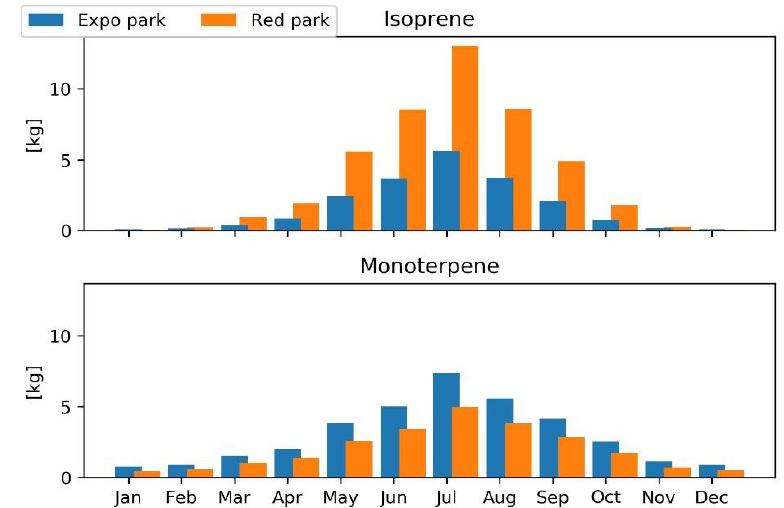
Figure 6. Monthly isoprene and monoterpenes emitted by EXPO and RED park of Tbilisi in 2018.